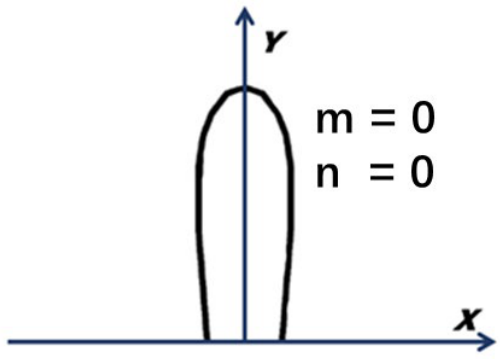
Figure 2. The diagram of radiated harmonics.